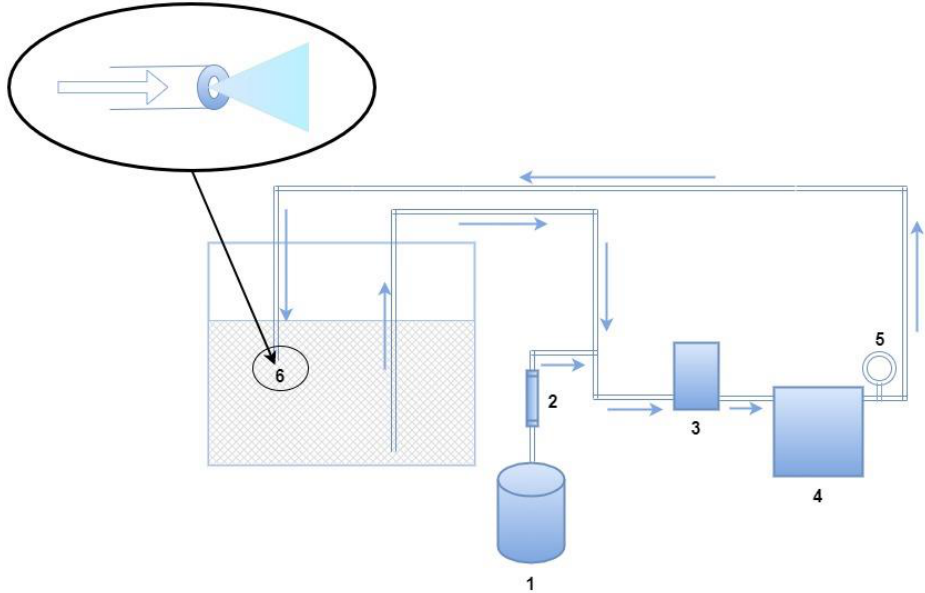
Figure 1. Schematic illustration of the MNB generator, where 1 represents the gas supply (CO 2 cylinders); 2 represents the gas flow meter; 3 represents the diaphragm pump; 4 represents the dissolved gas tank; 5 represents the hydraulic pressure gauge; 6 represents the throttling nozzle for the released gas. Table 1. Materials and reagents.